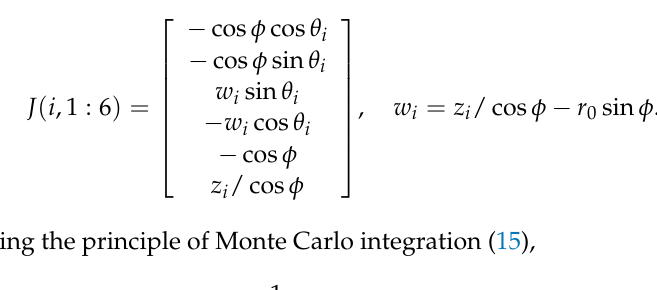
Table 6. Cone frustum of varying cone angle. Square roots s ( a ) of the diagonal elements of V a αφ as a function of φ . For points x 1: m approximately uniformly distributed over cone with cone angle φ , − π ≤ θ ≤ π and − a ≤ z ≤ a , a = 100 and point-cloud variance matrix V i i √ u ( a ) = σ R s ( a ) / m